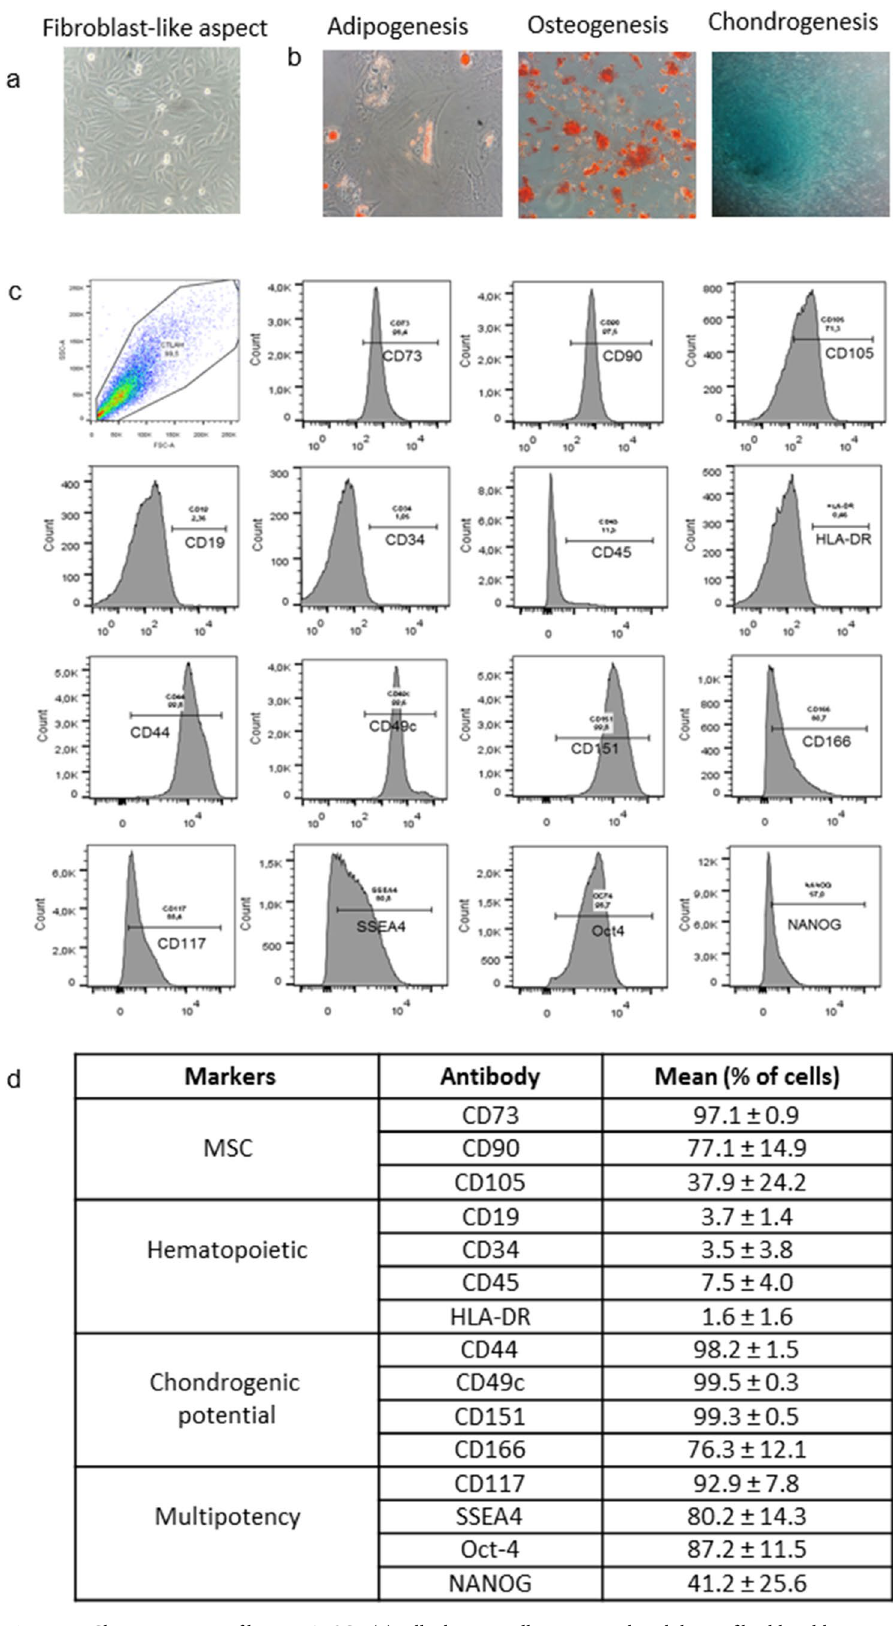
Figure 1. Characterization of human AFSCs: ( a ) cells showing adherent growth, exhibiting fibroblast-like aspect (400 ×); ( b ) differentiation potential in mesenchymal lineage after culture in specific medium (400 ×): adipogenic, oil Red O staining indicating lipidic vesicles; osteogenic, alizarin red staining indicating calcium matrix formation and chondrogenic, Alcian blue staining evidencing glycosaminoglycan presence; ( c ) immunophenotype analysis of AFSCs by flow cytometry; ( d ) percentage of cells showing specific markers of MSC, hematopoietic, multipotency, and chondrogenic potential in different